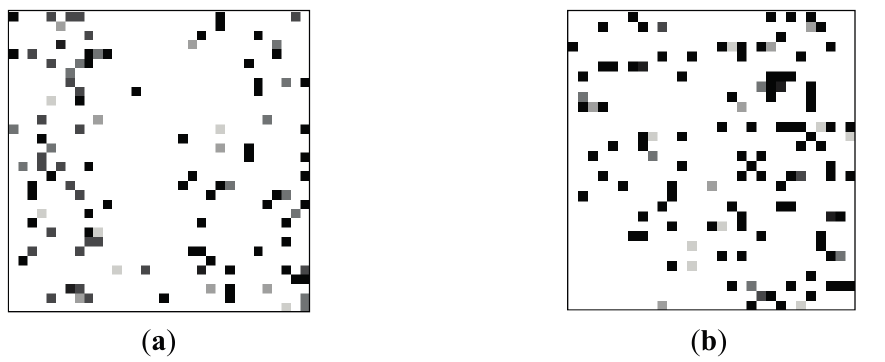
Figure 2. DRAM cells decay feature with power-switch interval time of 120 s: ( a ) DDR3 device 1; ( b ) DDR3 device